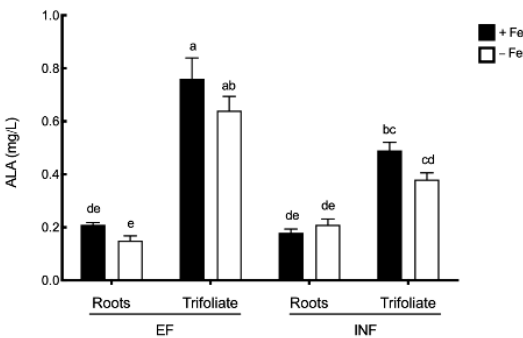
Figure 3. ∂ -aminolevulinic acid (ALA) concentration (mg/L) in roots or trifoliate leaves of efficient (EF) and inefficient (INF) soybean lines. Plants were grown under Fe sufficiency (+Fe, 20 µM) or Fe de fi ciency ( − Fe, no Fe) for 14 days under hydroponic conditions. Data are means ± SE; different letters indicate significant differences ( p < 0.05) by ANOVA with Tukey correction test. Total chlorophyll (Figure 4A), anthocyanin (Figure 4B), and carotenoid (Figure 4C) concentrations were evaluated. In the e ffi cient plants, Fe stress induced decreases between 30% and 39% of these pigment concentrations, but in the ine ffi cient plants, Fe availability did not significantly a ff ect the photosynthetic pigments accumulation. On the other hand, ine ffi cient plants presented significantly lower total chlorophyll (Figure 4A) and carotenoids (Figure 4C) concentrations when compared to the e ffi cient